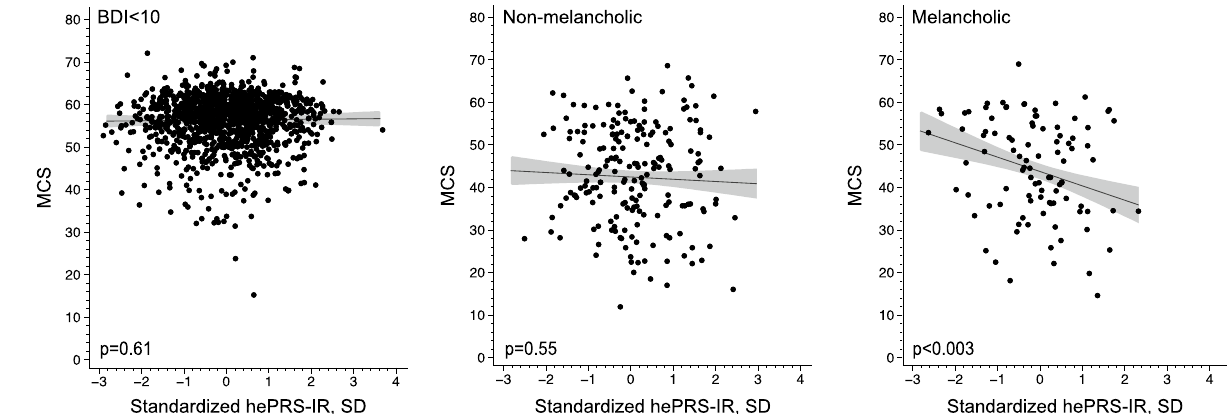
Figure 2. Association between the biologically informed hippocampal polygenic risk score for the insulin receptor gene network (hePRS-IR) and mental component score of the SF-36 (MCS) in individuals with no, non-melancholic or melancholic depressive symptoms. Confidence intervals and P-values were based on the bootstrap style method of 10,000 repetitions. ( a ) BDI < 10. ( b ) Non-melancholic depressive symptoms. ( c ) Melancholic depressive symptoms. Model adjusted for age, sex and population stratification, smoking, alcohol usage, socioeconomic class, body mass index, leisure-time physical activity and comorbidities. MCS mental component score of SF-36, BDI Beck Depression Inventory, hePRS-IR biologically informed hippocampal polygenic risk score for insulin receptor, SD standard